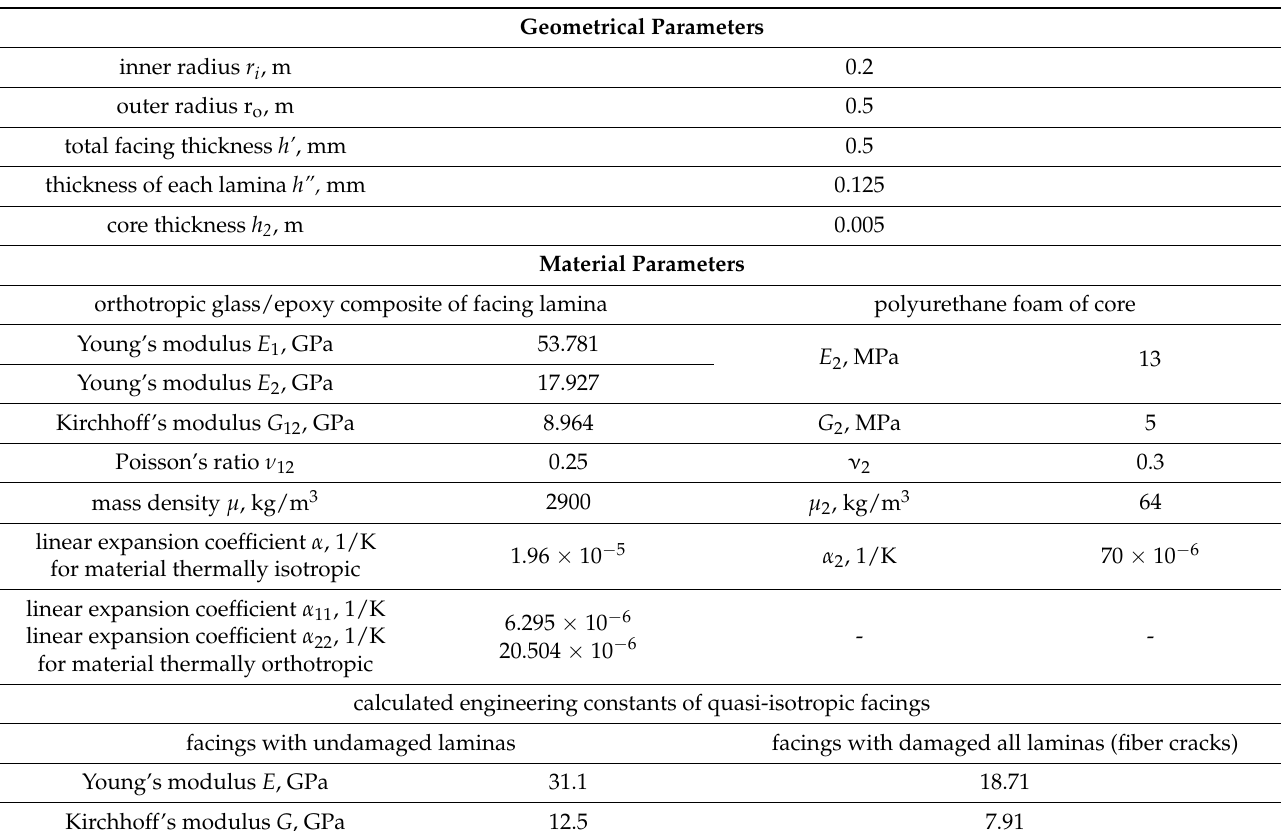
Table 3. Material, geometrical and loading parameters of examined plate models.